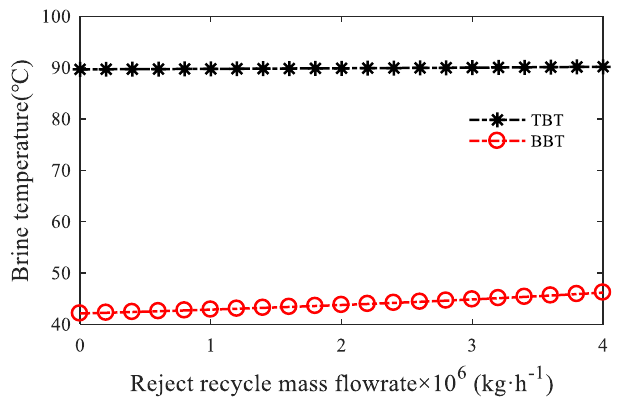
Figure 6. E ff ect of reject recycle mass flowrate ( S ) on brine temperature (TBT and BBT). Figure 6. Effect of reject recycle mass flowrate ( S ) on brine temperature (TBT and BBT).